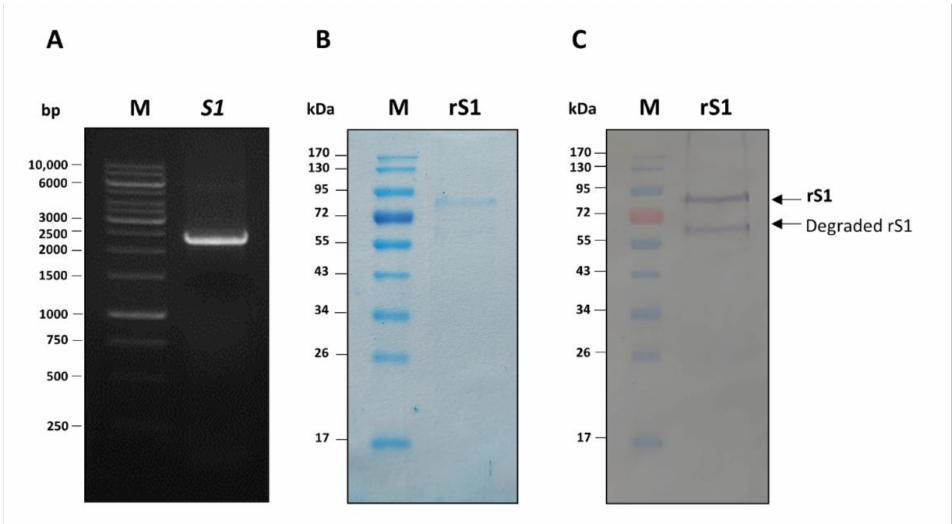
Figure 1. Production of recombinant S1 (rS1) of porcine epidemic diarrhea virus (PEDV). ( A ) Poly- merase chain reaction (PCR) amplificon of PEDV S1 gene ( S1 ). Lane M, 1 kilobase (kb) DNA ladder. Numbers on the left are DNA sizes in base pairs (bp). ( B ) Sodium dodecyl sulfate-polyacrylamide gel electrophoresis (SDS-PAGE) separated pattern of the purified rS1 protein after staining with Coomassie Brilliant Blue G-250 (CBB) dye. ( C ) Western blot pattern of the rS1 as detected by anti-His antibody. Lanes M and numbers on the left of ( B ) and ( C ) are protein molecular mass marker and protein molecular masses in kilo-Daltons (kDa),